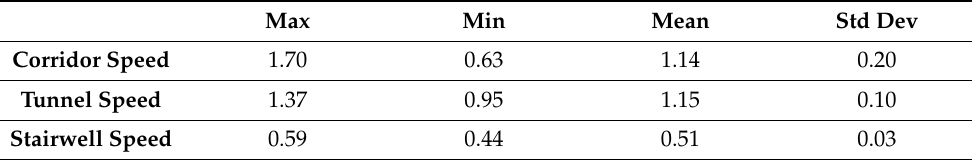
Table 3. Occupants’ speed (m/s) distribution in drill no.1 (clear